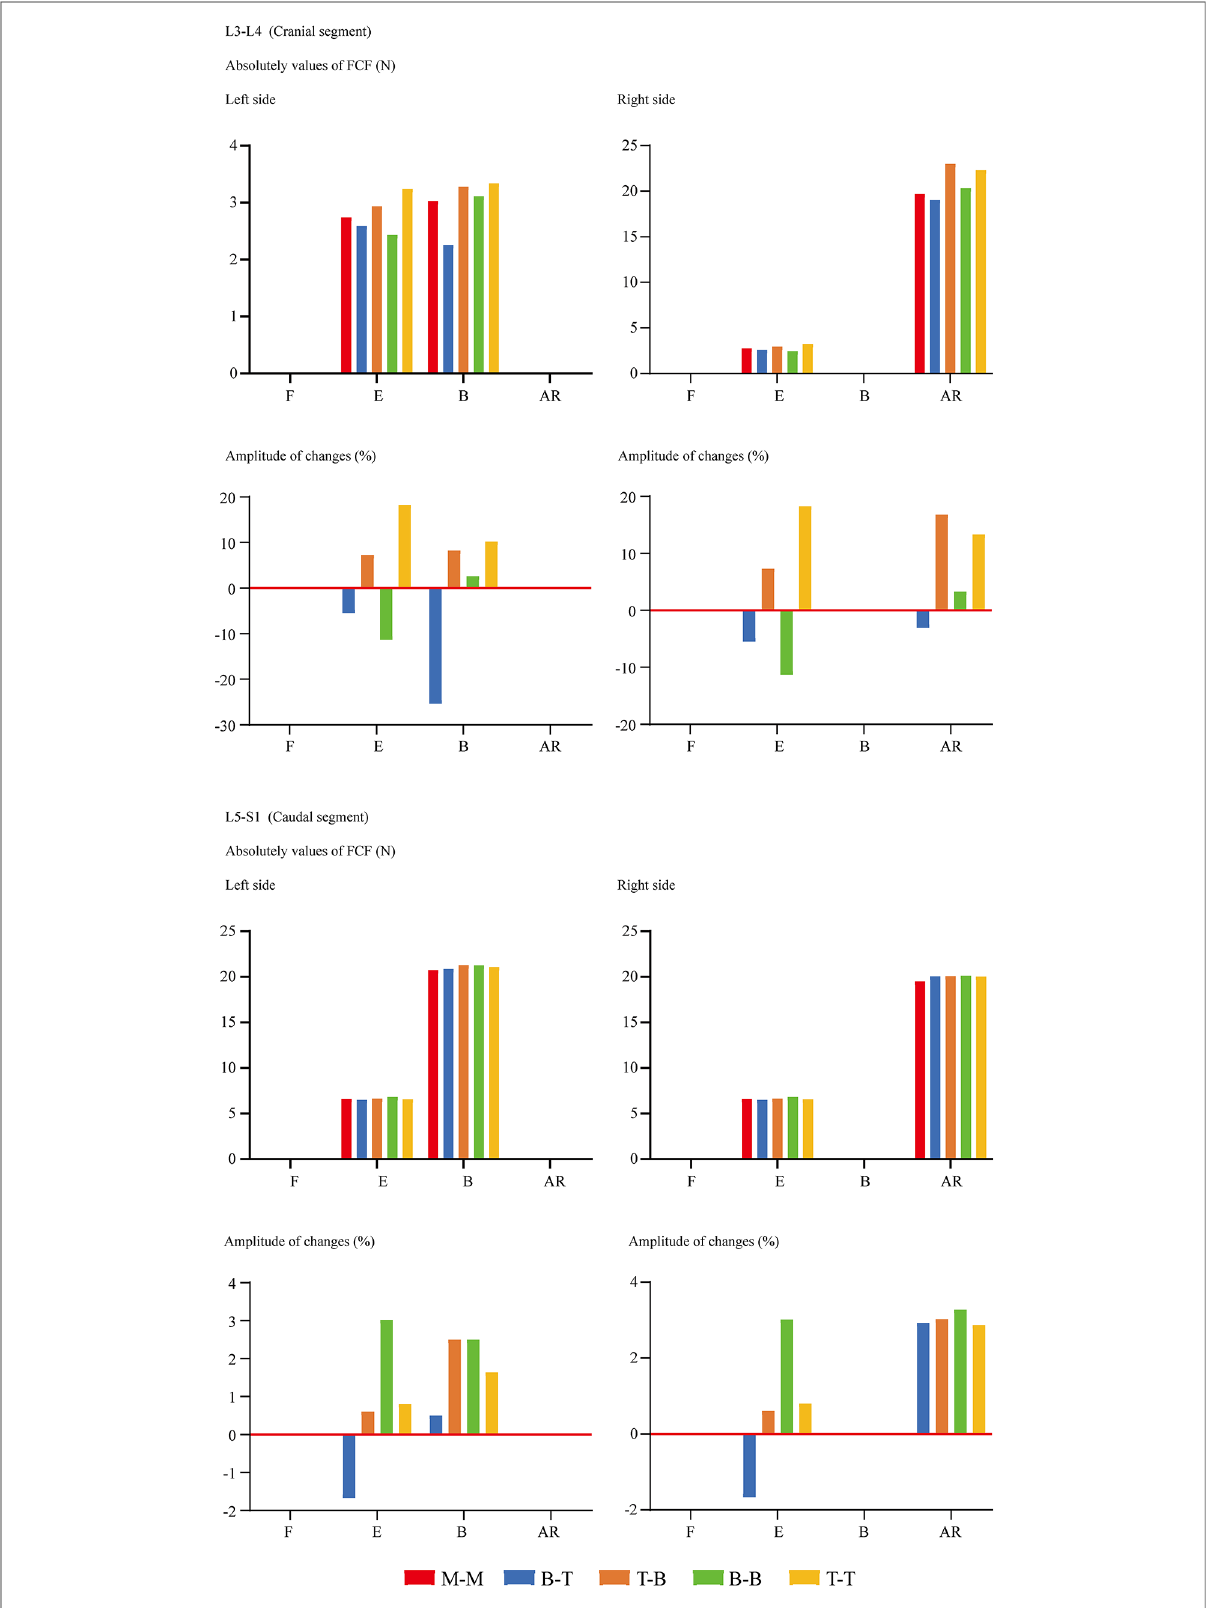
FIGURE 4 Comparison of FCF between surgical models with different insertional screw positions. F, Flexion; E, Extension; B, Bending; AR, Axial